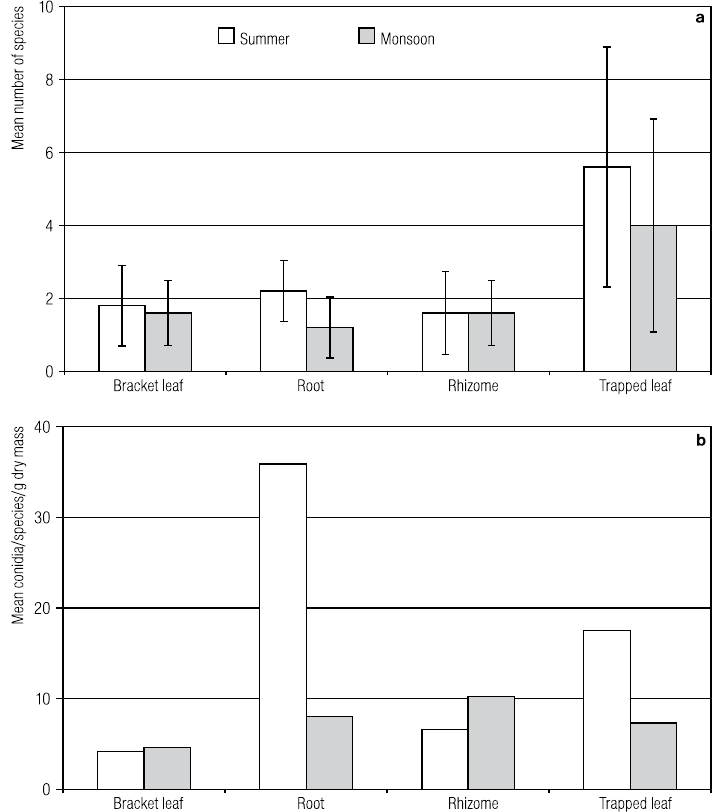
Fig. 2. Mean number of species (a) (n=5, mean ± SD) and mean conidia (n=5) per species per gram dry mass (b) of bracket leaf, root, rhizome ( Drynaria quercifolia ) and trapped leaf litter of Sampaje region.